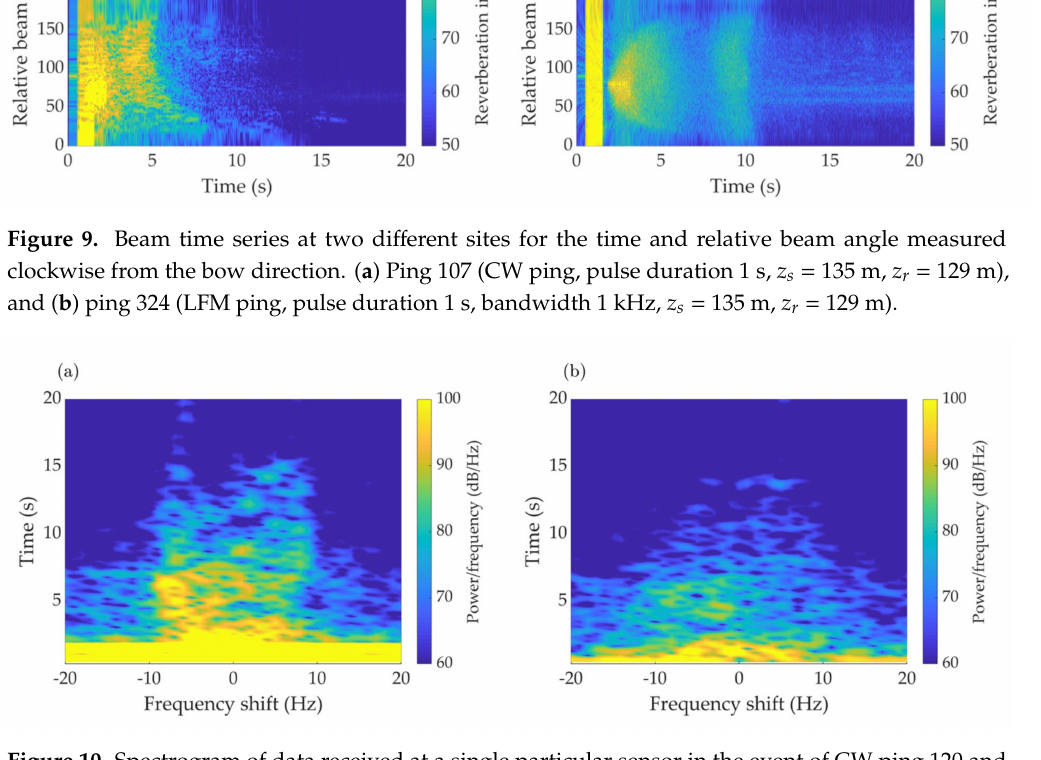
Figure 10. Spectrogram of data received at a single particular sensor in the event of CW ping 120 and CW ping 121. ( a ) Pulse duration 1 s, ( b ) Pulse duration 0.1